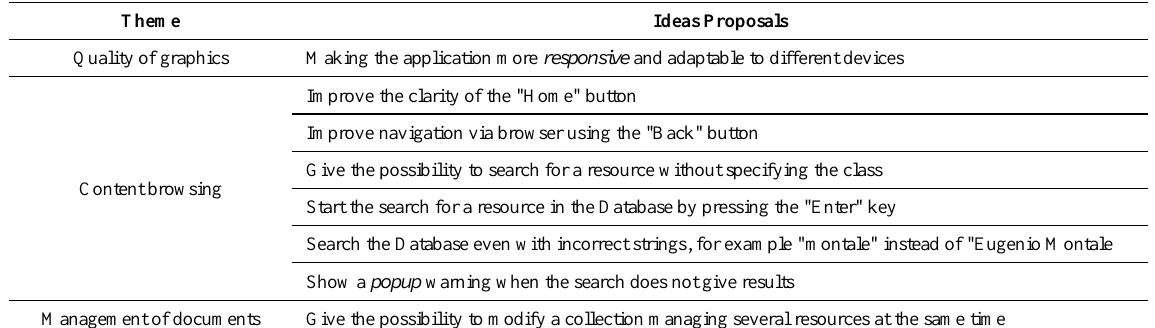
Table 3. User suggestions divided by category